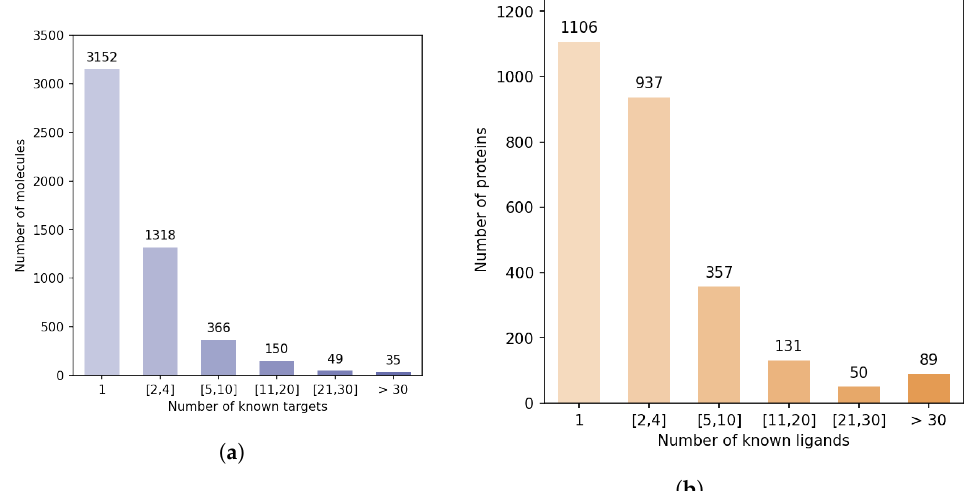
Figure 5. Statistical bias in the DB-Database. ( a ) Distribution of the molecules according to their number of targets in the DB-Database. ( b ) Distribution of the proteins according to their number of ligands in the